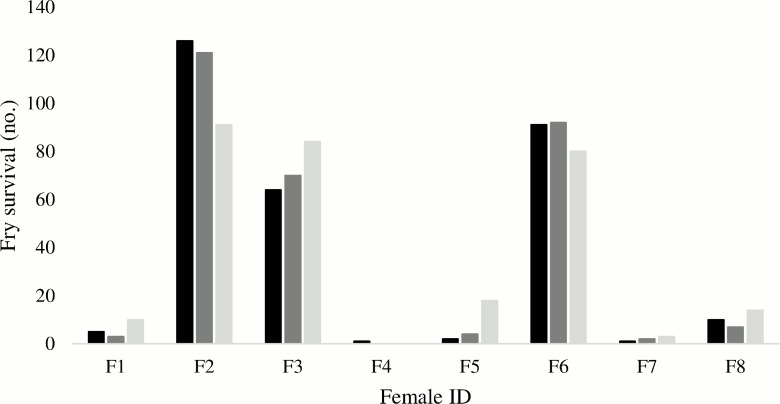
Survival numbers of post-metamorphosis progeny per replicate tank.Black, dark grey and light grey bars represent tank 1, 2 and 3, respectively.